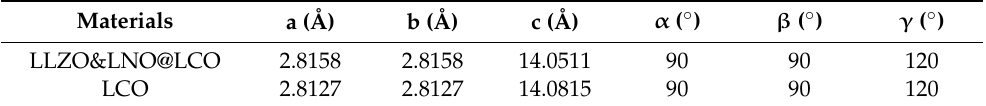
Figure 3. Elemental O, Co, Zr, Nb, and La mapping of LLZO&LNO@LCO. X-ray diffraction (XRD) was also conducted to determine the crystallinity of the LCO and LLZO&LNO@LCO to examine the influence of the coating on LCO structure. LCO is the stably layered α -NaFeO 2 type with R 3̅ m space group. LLZO&LNO@LCO ex- hibited strong XRD patterns associated with LCO, as shown in Figure 4A. Most of the diffraction peaks in the patterns were related to layered α -NaFeO 2 structures corre- sponding to the space group of R 3 ̅ m . LLZO&LNO@LCO and LCO matched well with